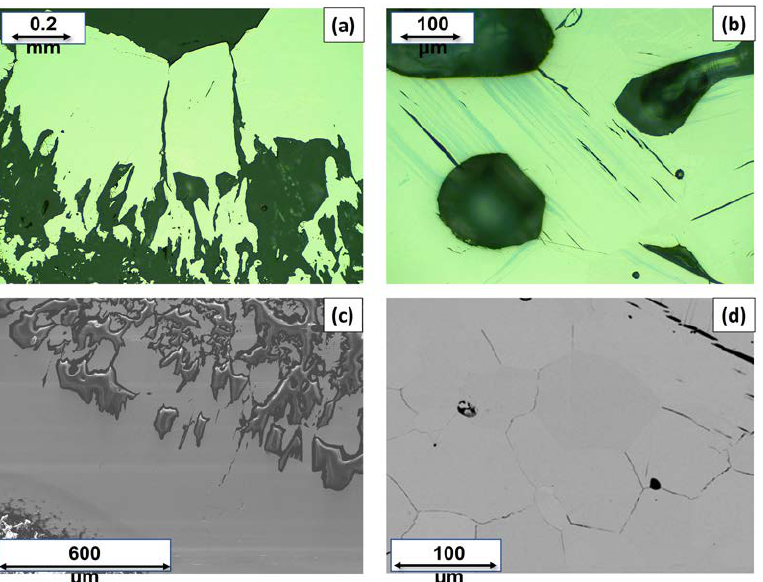
Figure 1. LOM images of the Cu 3 As samples synthesized at 350 °C—13 days ( a ) and at 500 °C—16 days ( b ). SEM microphotographs in Back-Scattered-Electron (BSE) mode of the same samples: 350 °C—13 days ( c ) and 500 °C—16 days ( d ).